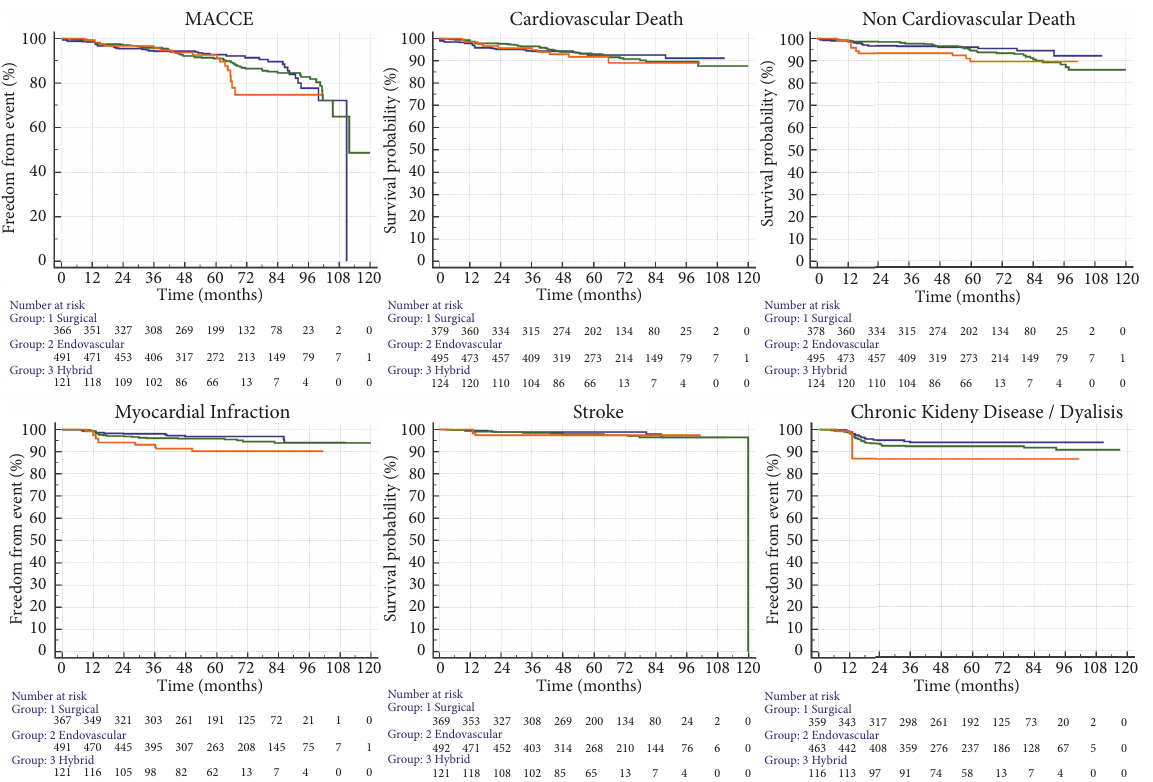
Figure 1: Kaplan-Meier curves for the 5-year primary and secondary endpoints. The Kaplan-Meier curves for the 5-year primary and secondary endpoints are shown for the 3 approaches. Blue lines represent the surgical group (1), green lines the endovascular group, (2) and orange lines the hybrid group